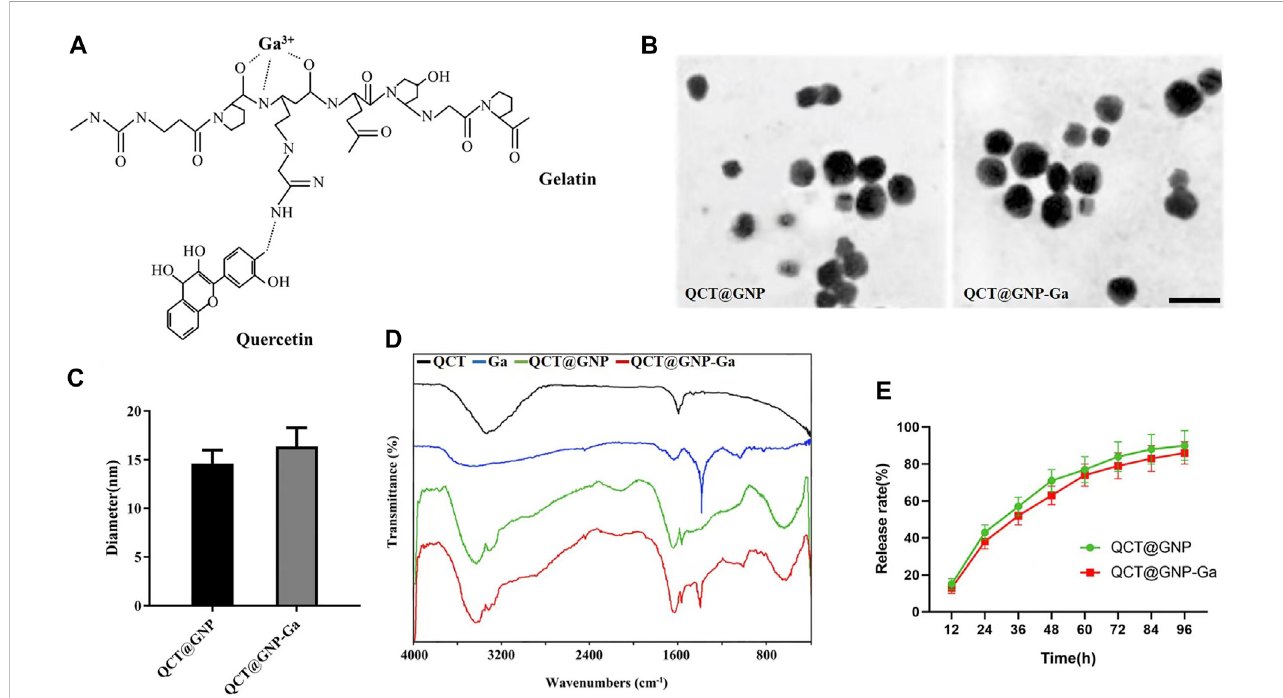
FIGURE 1 Characterization of QCT@GNP-Ga. (A) A schematic view of the design of gallium-modi fi ed gelatin nanoparticles loaded with quercetin. (B) Representative image TEM images of QCT@GNP and QCT@GNP-Ga, Scale bar = 20 nm. (C) Particle size of QCT@GNP and QCT@GNP-Ga. (D) FTIR spectra of QCT, Ga, QCT@GNP, and QCT@GNP-Ga. (E) QCT release from QCT@GNP and